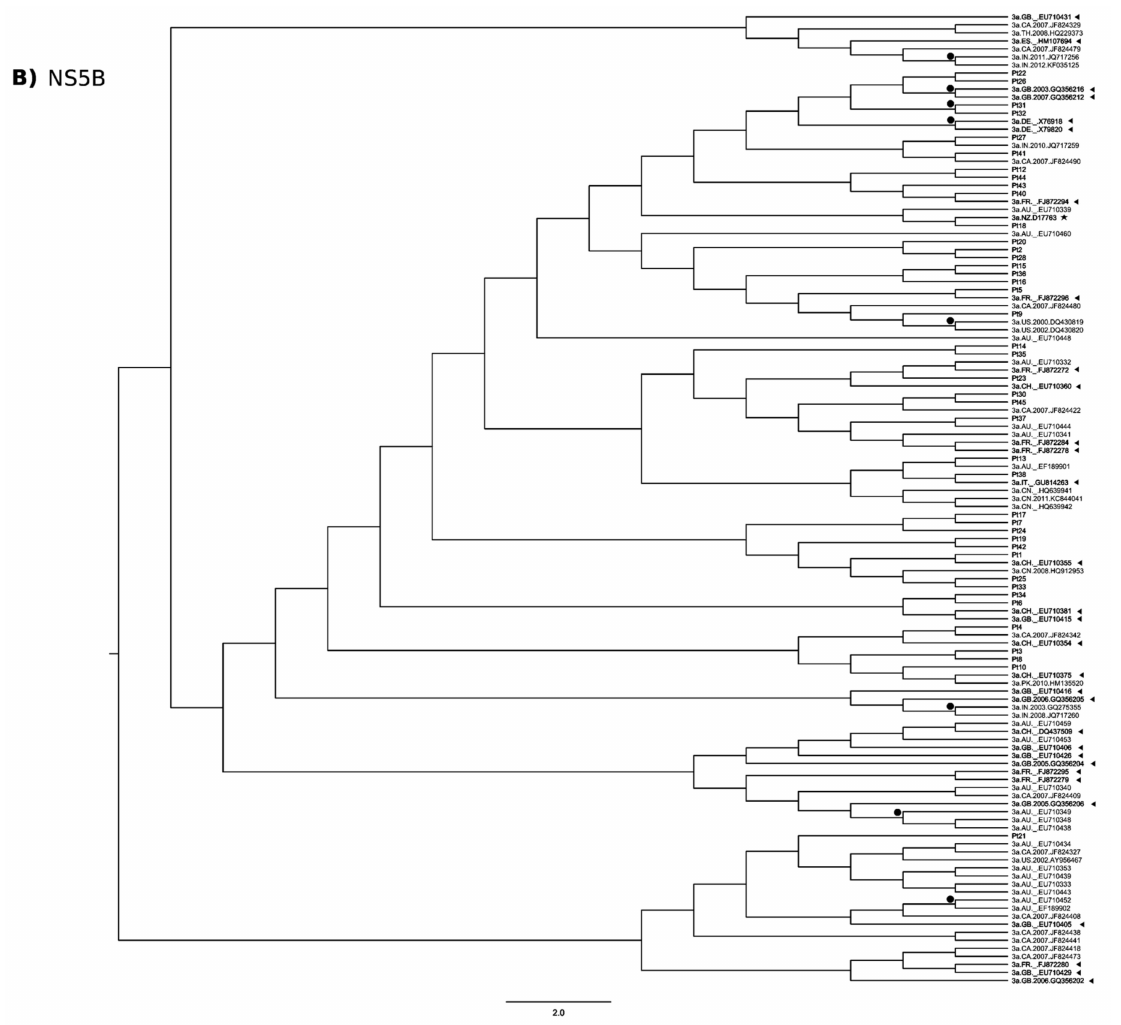
Figure 2. Phylogenetic trees of NS5A and NS5B. Phylogenetic analyses of: NS5A ( A ); and NS5B ( B ) sequences performed using 500 bootstrap repetitions. Only bootstrap values >70% are outlined with black circles. Sequences from the present study are indicated with patient (Pt) number; HCV sequences from European countries in the Los Alamos database are shown with black triangles. The country and year of these sequences are reported after the genotype. The GT3a reference sequence (D17763, in black star) is included. Patients harboring NS5A-A30K are side marked. AU, Australia; CA, Canada; CH, Switzerland; CN, China; DE, Germany; FR, France; GB, Great Britain; IN, India; ITA, Italy; PK, Pakistan; US, United States; NZ, New